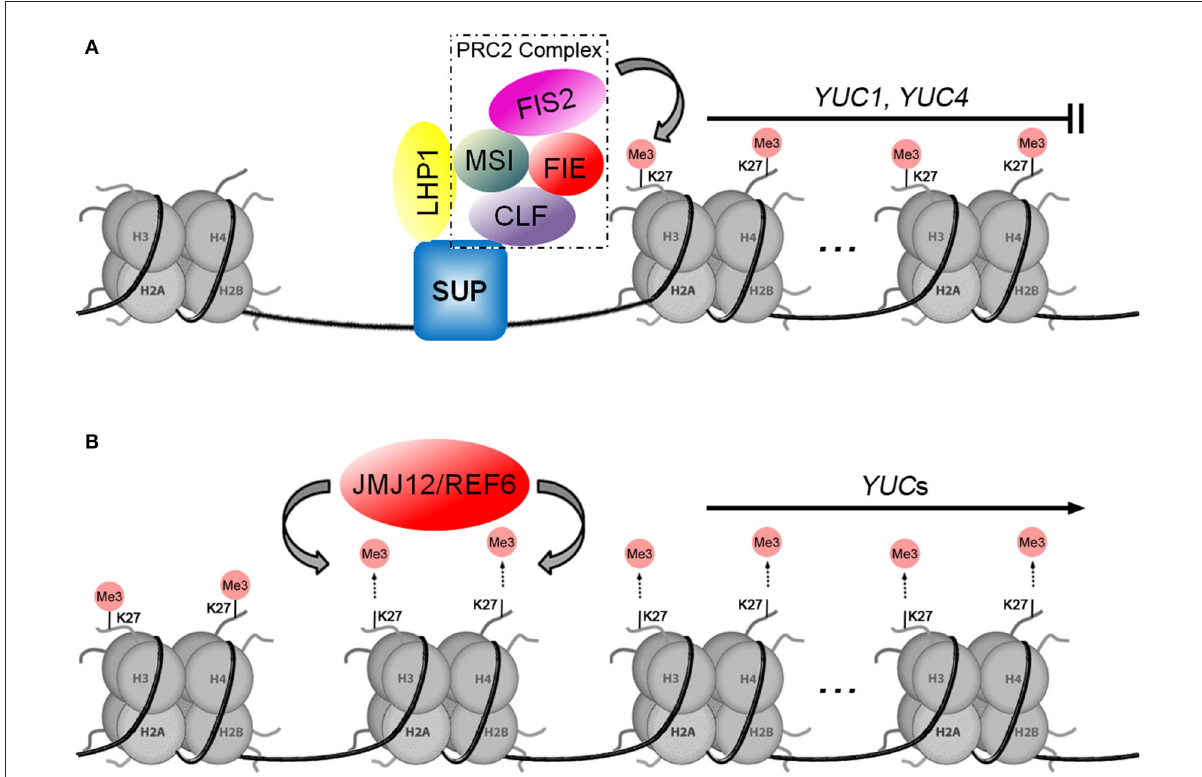
FIGURE2 Two models for histone methylation are involved in the transcriptional regulation of YUC s. (A) Model of how H3K27me3 by the PRC2 complex inhibits the expression of auxin biosynthetic genes. (B) The JMJ12/REF6 histone demethylase positively regulates YUC s by demethylation of histone